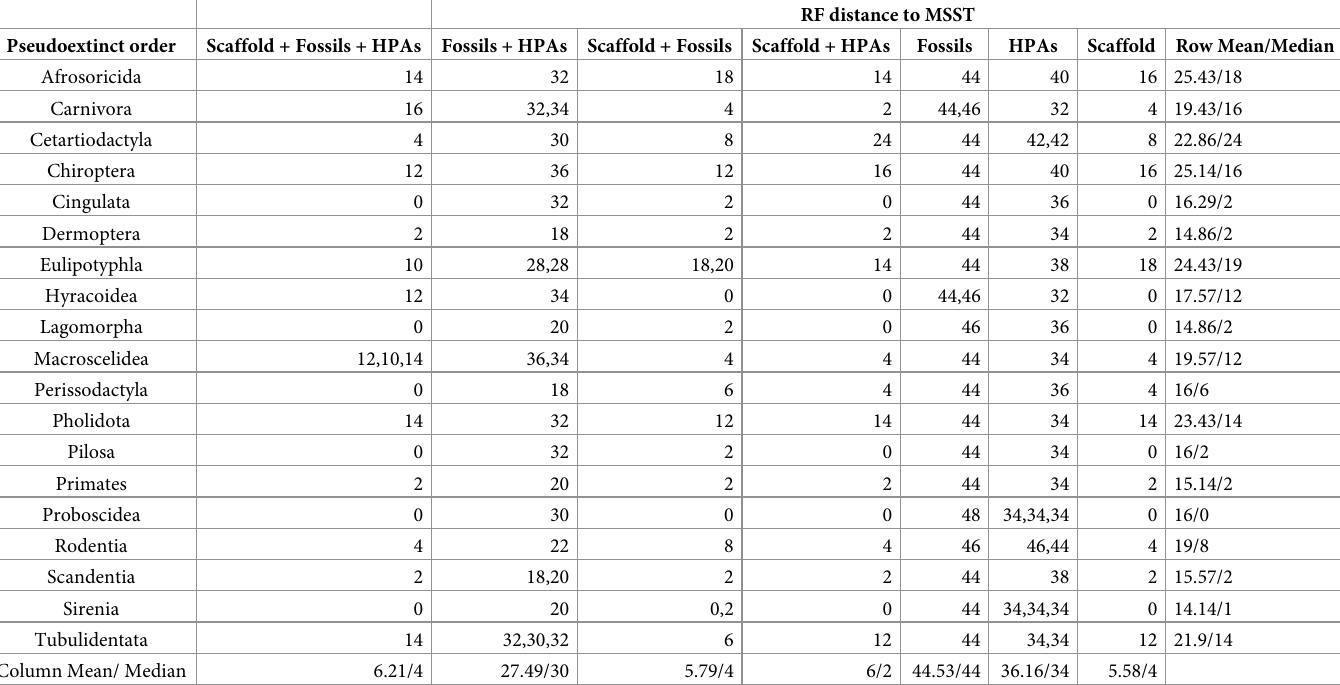
Table 1. Summary of Robinson-Foulds comparisons.